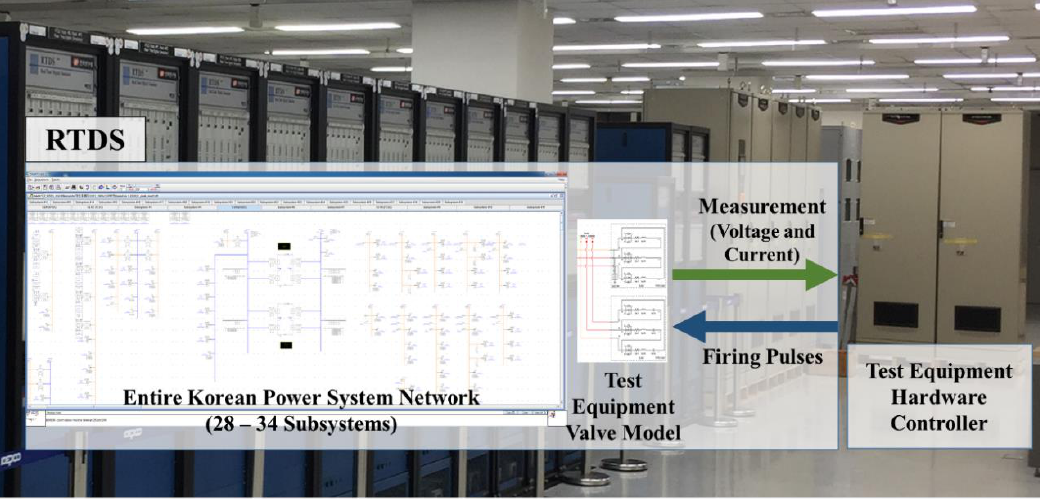
Figure 1. Configuration of dynamic performance test (DPT) for equipment.